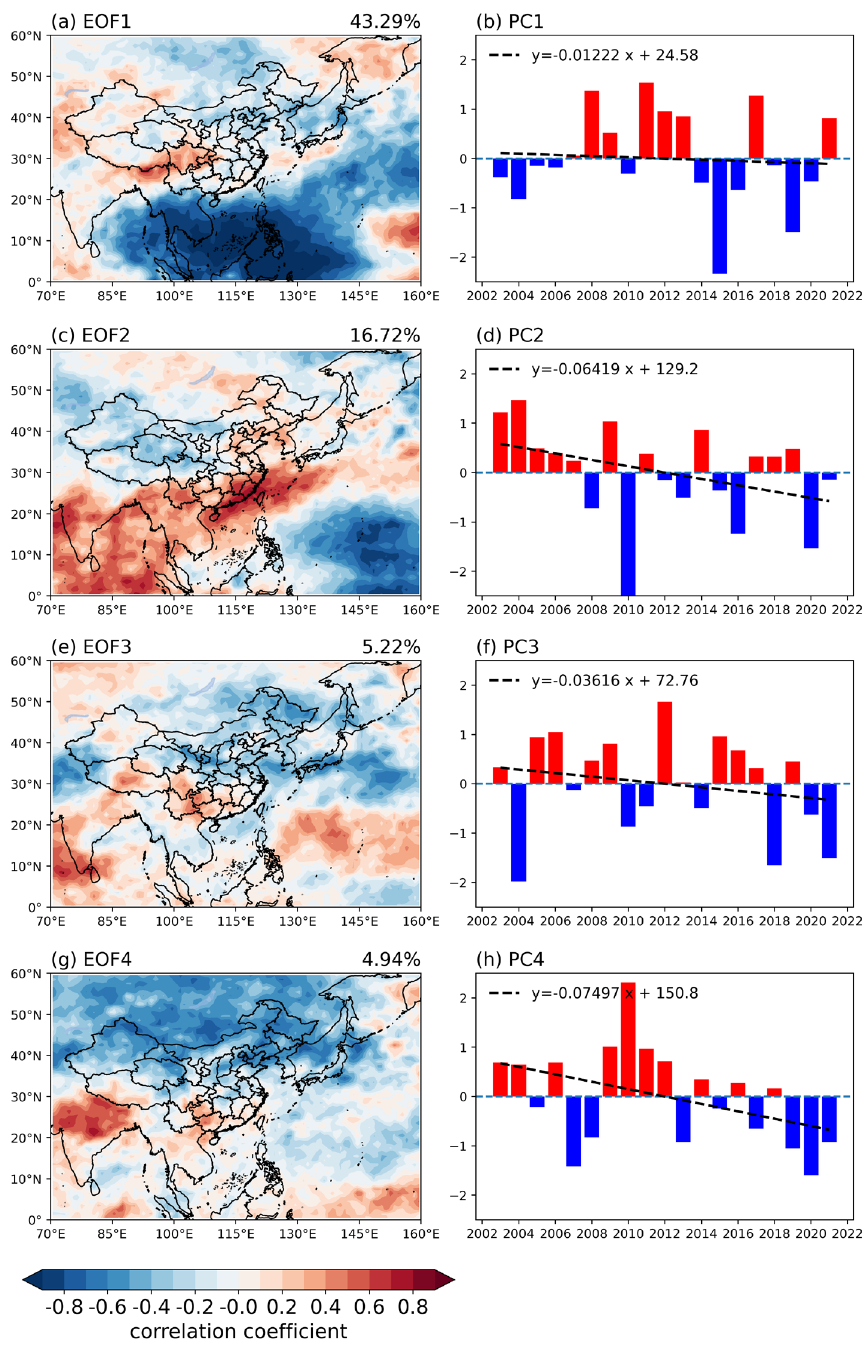
Figure 7. The result of empirical orthogonal decomposition in East Asia